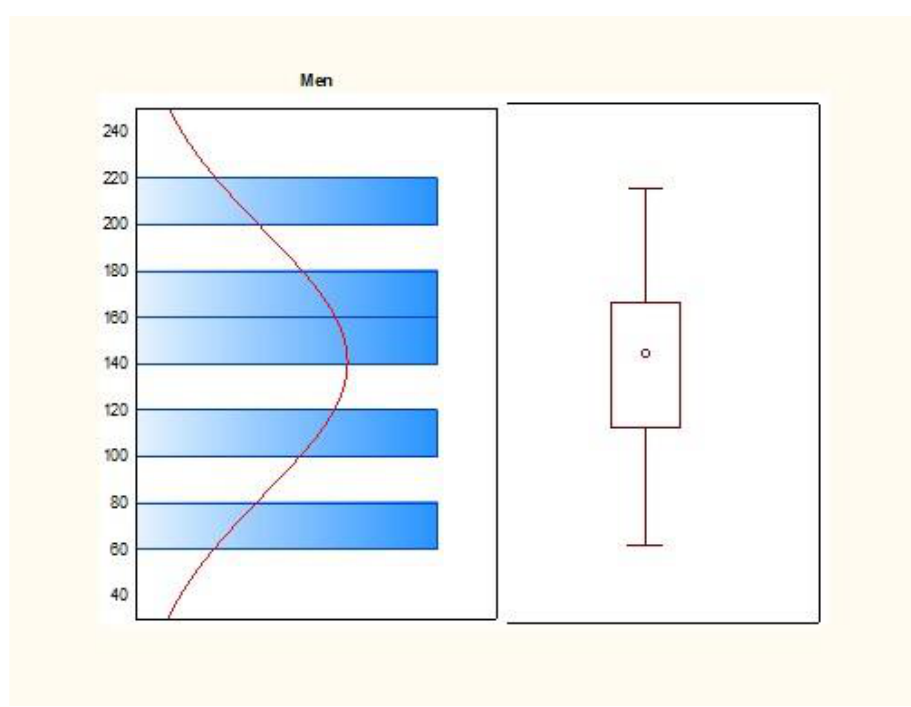
Figure 19. Employee structure by gender and performance data.